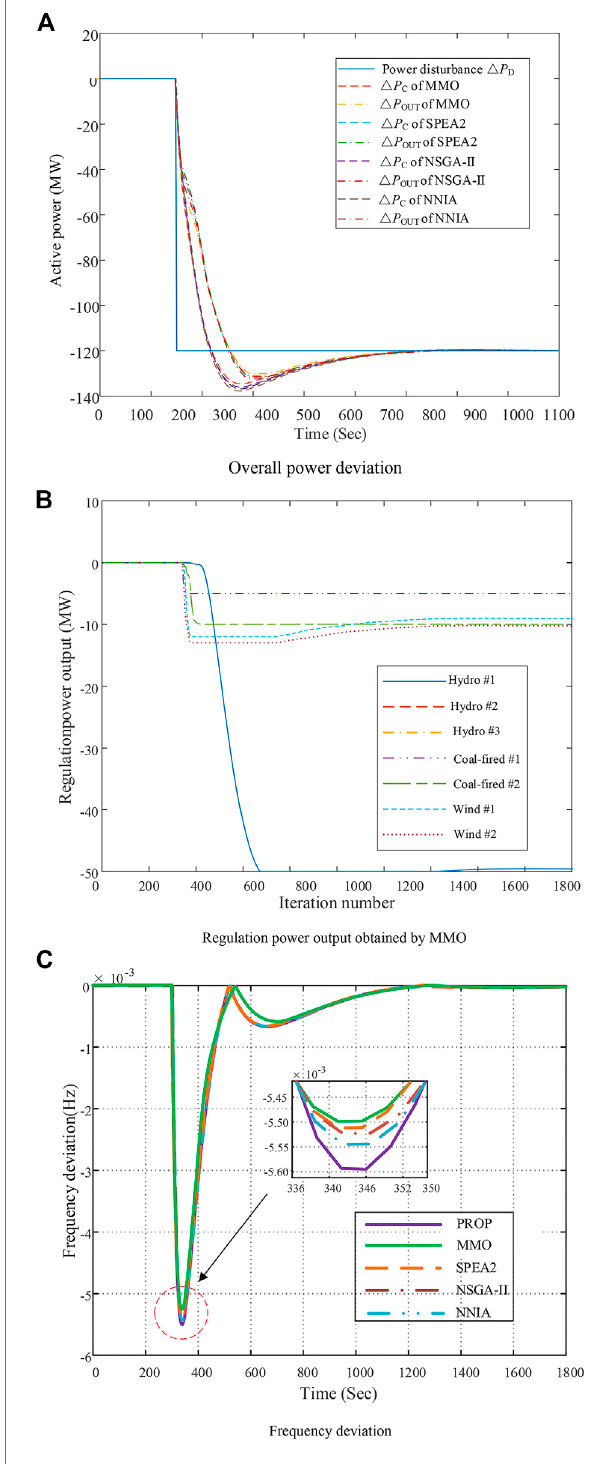
FIGURE 7 | Real-time optimization results under Δ P D = − 120 MW. (A) Overall power deviation. (B) Regulation power output obtained by MMO. (C) Frequency